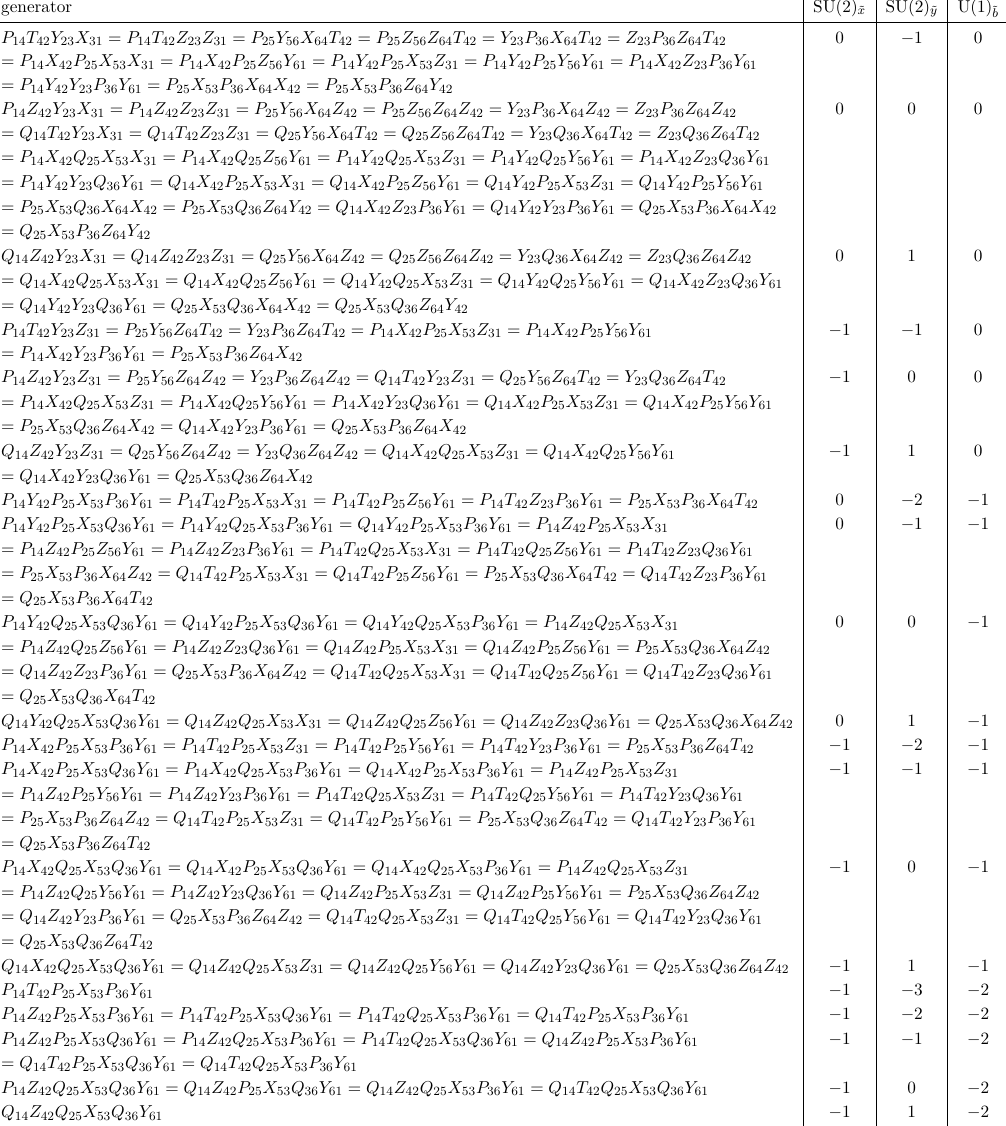
Table 18 . The generators in terms of bifundamental chiral fields for Model 4 (Part 2) .